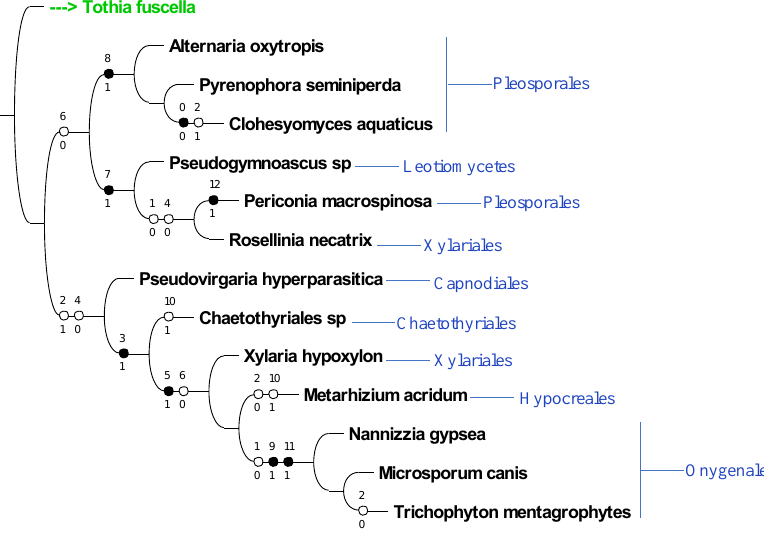
Figure 9. Binary phylogenetic tree of the presence or absence of intergenic region combinations (characters) in representative fungi. The 0–12 numbers on top of each circle represent character number with 0 being assigned to swnH2 – swnK (see Table 2). The 0 and 1 under each circle represent absence (0) or presence (1) of that character. The closed circles indicate that the character only changes at that one spot on the tree, and the open circles indicate changes elsewhere on the tree also.